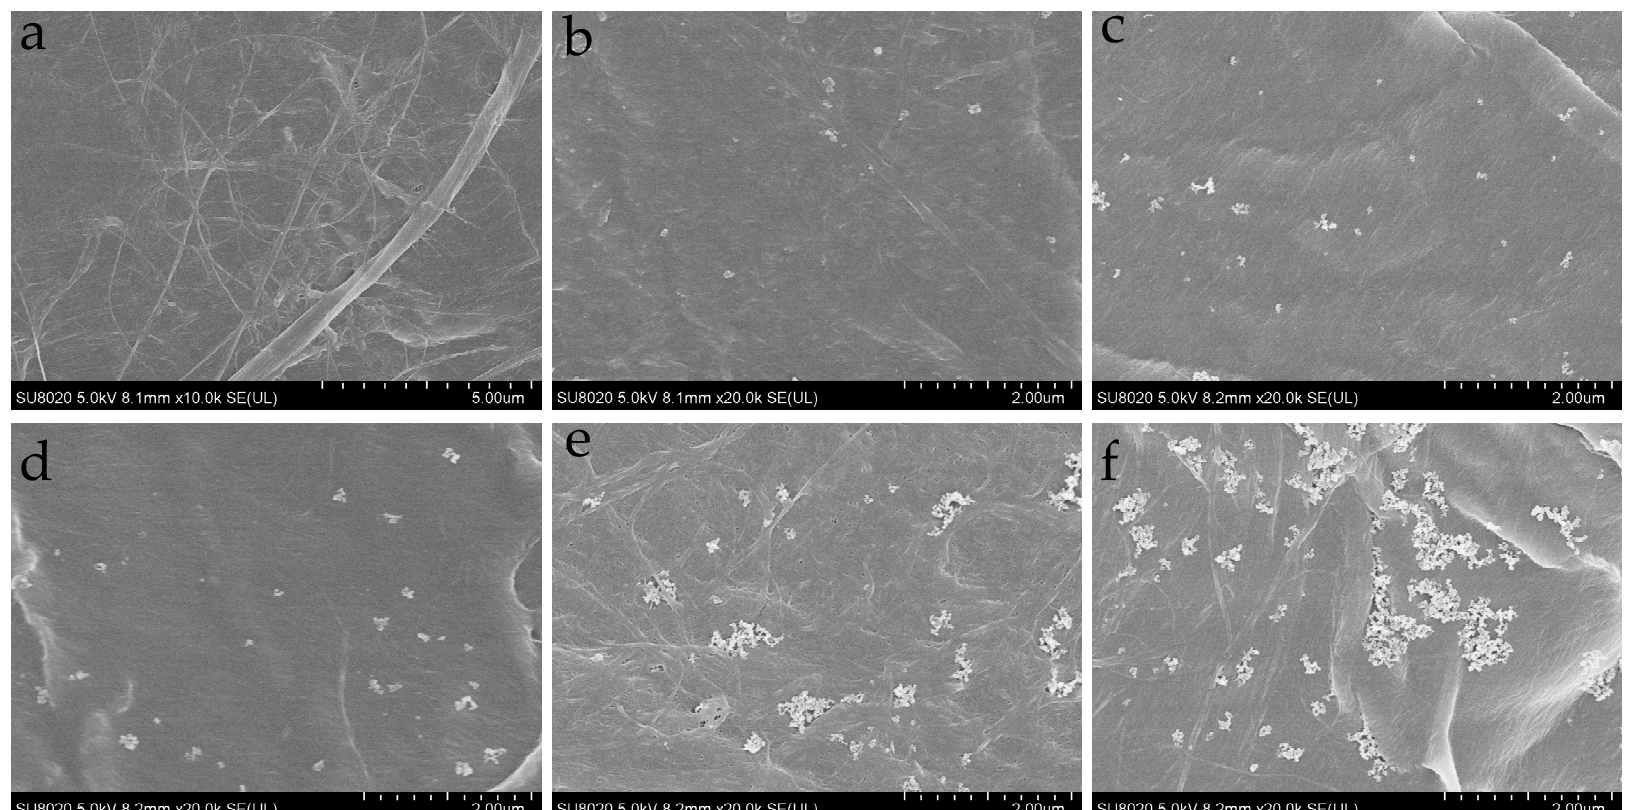
Figure 4. ( a ) SEM (scanning electron microscopy) micrographs of unmodified pressboard; ( b ) SEM micrographs of modified pressboard with 0.5 wt % SiO 2 ; ( c ) SEM micrographs of modified pressboard with 1 wt % SiO 2 ; ( d ) SEM micrographs of modified pressboard with 2 wt % SiO 2 ; ( e ) SEM micrographs of modified pressboard with 3 wt % SiO 2 ; ( f ) SEM micrographs of not modified pressboard wit 4 wt % SiO